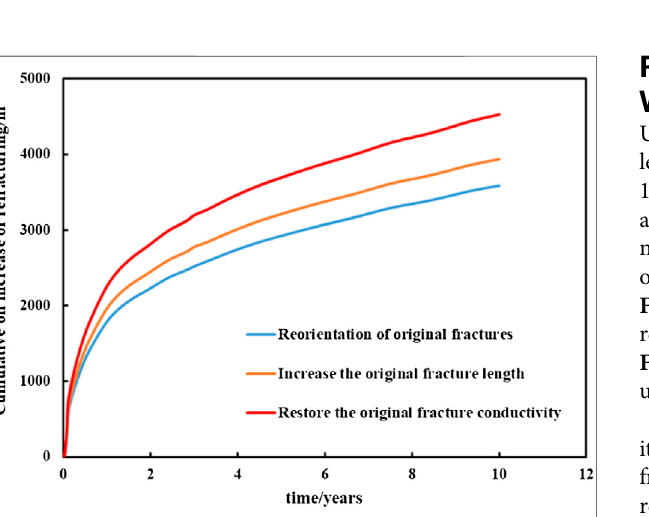
FIGURE 13 | Change of cumulative oil increment in ten years of test